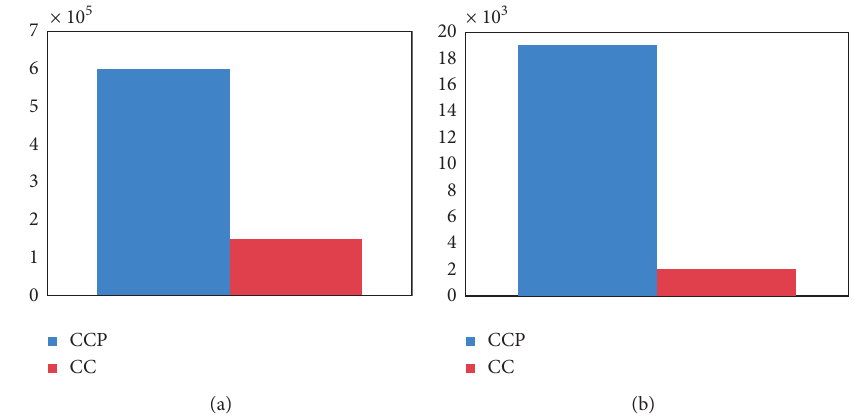
Figure 6: Environmental impact of CC [15]: (a) CO